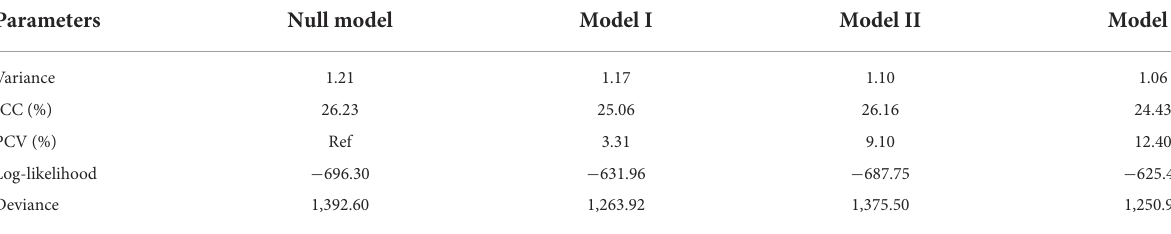
TABLE 2 Model comparison and random effect analysis result in